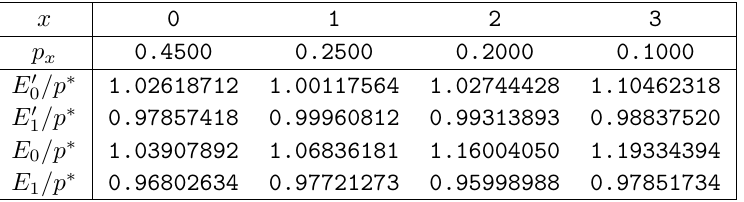
Table 1: An example of increasing and decreasing